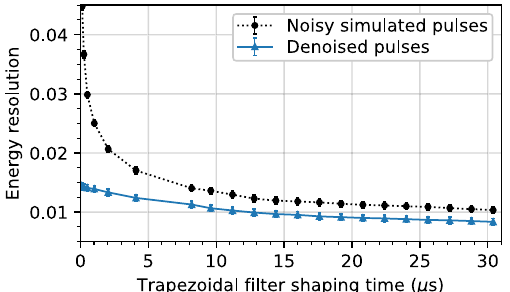
Fig. 6 Energy resolution, defined as the FWHM of the energy dis- tribution, as a function of trapezoidal filter shaping time. Calculated on library pulses with real detector noise with a baseline RMS of 0.1 before denoising (dotted line, circle markers) and after denoising with the amplitude normalized model (solid line, triangle markers)